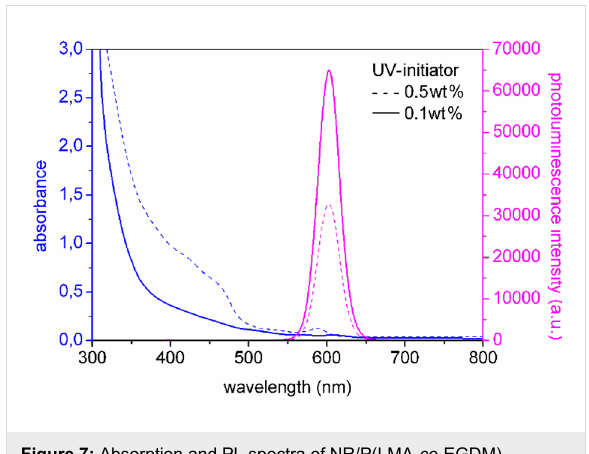
Figure 7: Absorption and PL spectra of NR/P(LMA- co -EGDM) composites containing 0.05 wt % NRs (aspect ratio 6) with low (0.1 wt %, solid line) and high (0.5 wt %, dotted line) UV-initiator concentra-